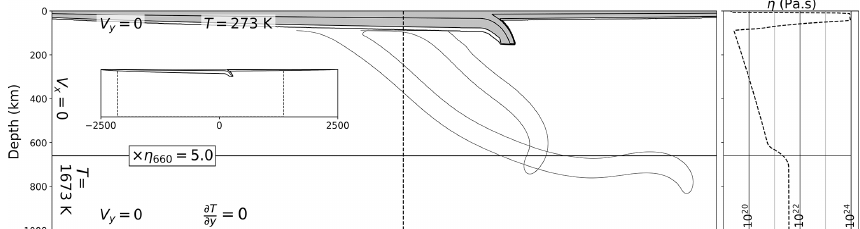
Figure 2. Initial conditions for 2-D thermo-mechanical subduction models. All models in this study have a 50Myr initial slab age. Velocity boundary conditions are free slip on all walls of the domain (zero tangential stress). The dark grey region in the main panel shows parts of the model colder than 1100 ◦ C. The inset shows the full domain. Outlines show the slab position at 10 and 20Myr. The right-hand panel shows the viscosity profile evaluated along the vertical dashed line in the main panel.